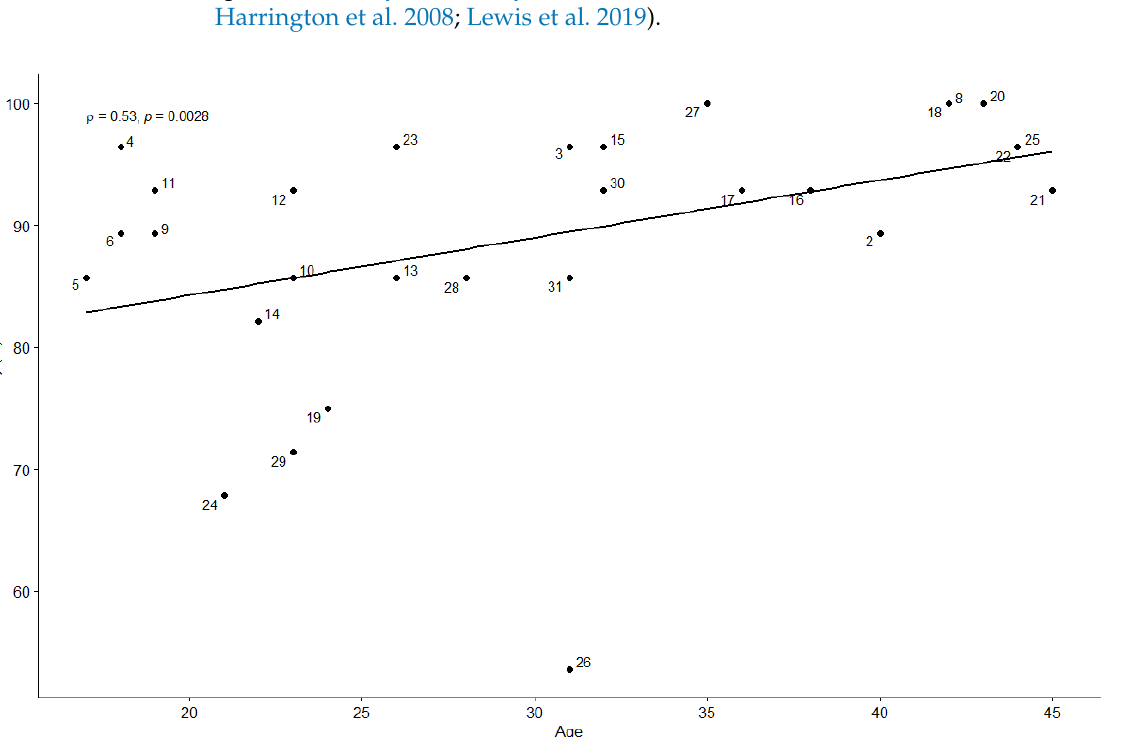
Figure 5. Scatterplots displaying the relationship between age and percentage accuracy in the iden- tification of the contrast between /c/ and / ʧ /: ( a ) depicts results for females; ( b ) shows the results for males. Spearman’s correlation coefficient is indicated by ρ. Corresponding p -values are found to the right of each coefficient value.